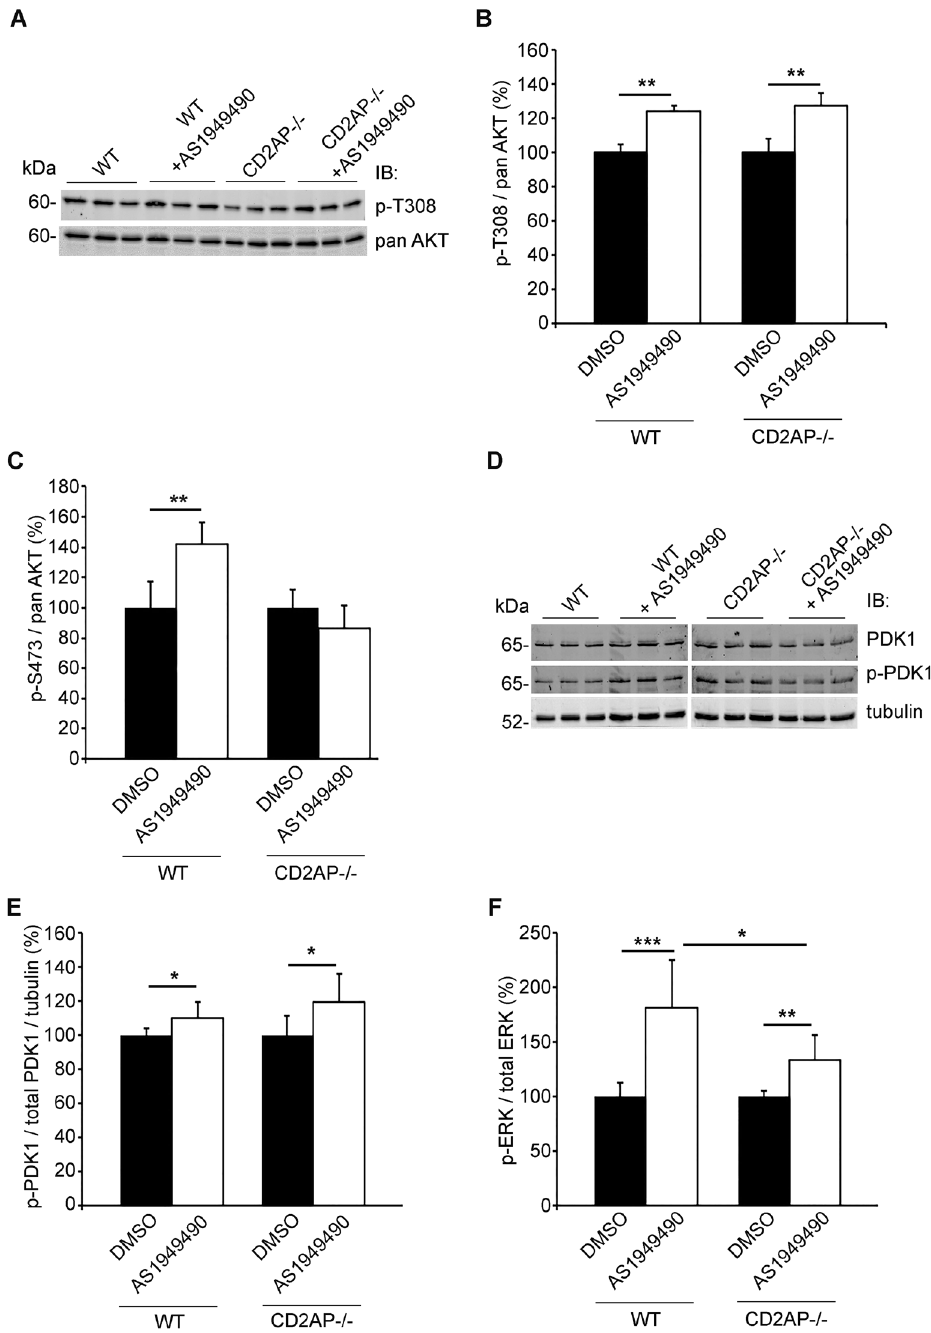
Figure 3. SHIP2 inhibition diminishes activation of AKT and ERK signalling pathways in CD2AP-deficient podocytes. ( A ) Representative immunoblot used for quantifying T308 phosphorylation of AKT in WT and CD2AP − / − podocytes treated or not with AS1949490. ( B ) Quantification of three replicate immunoblots as in ( A ) reveals that AS1949490 treatment increases T308 phosphorylation of AKT (p-T308) in both WT and CD2AP − / − podocytes. (C) In-cell Western and quantification shows that AS1949490 treatment increases S473 phosphorylation of AKT (p-S473) in WT podocytes but not in CD2AP − / − podocytes. Phosphorylated AKT (S473) and total AKT (panAKT) were both normalized to nuclear marker DRAQ5 TM . (D) Representative immunoblot used for quantifying p-PDK1 in WT and CD2AP − / − podocytes treated or not with AS1949490. (E) Quantification of three replicate immunoblots as in (D) reveals that AS1949490 treatment increases relative phosphorylation of PDK1 in both WT and CD2AP − / − podocytes. p-PDK1 and total PDK1 were normalized to tubulin before calculation of the ratio. (F) In-cell Western and quantification reveals that AS1949490 treatment increases the phosphorylation of ERK (p-ERK) in both WT and CD2AP − / − podocytes, but the response remains significantly lower in the absence of CD2AP. The experiments were performed three times with three replicates in each experiment. The bars show the mean expression in arbitrary units (error bars STDEV). * p < 0.05, ** p < 0.01, *** p < 0.001, Student’s